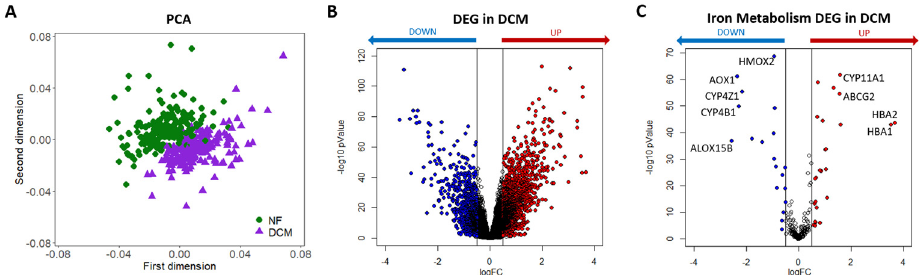
Figure 1. Differentially expressed genes in heart failure (HF). ( A ) Principal component analysis (PCA) of RNA-seq data. Each dot represents one sample. Green circles: non-failing subjects (NF). Purple triangles: dilated cardiomyopathy (DCM) patients. ( B ) Volcano plot showing the results of the differential expression analysis of DCM with respect to NF, on the entire set of genes. ( C ) Volcano plot showing just the iron-linked genes were significantly regulated in DCM. The genes with |log(FC)| ≥ 0.5 and adjusted p Value < 0.05 are regarded as the differentially expressed genes (DEGs) in DCM in comparison to the NF group. In particular, red and blue dots denote significantly up-regulated (adjusted p Value < 0.05 and log(FC) ≥ 0.5) and down-regulated (adjusted p Value < 0.05 and log(FC) ≤ − 0.5) genes in DCM, respectively. The empty dots represent the unchanged